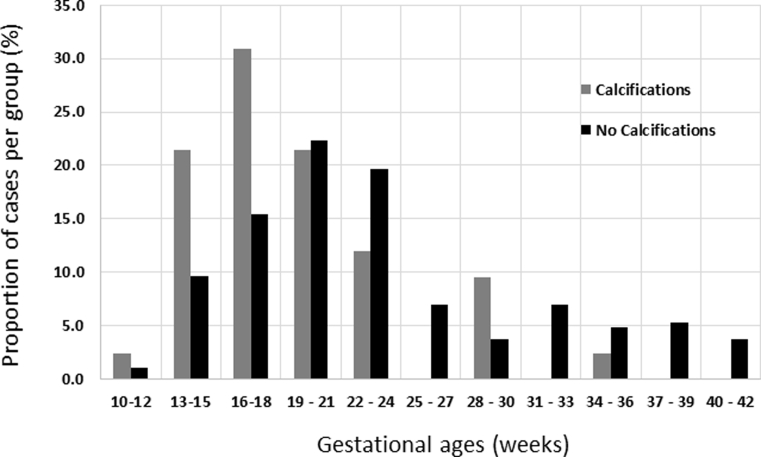
Graph illustrating the proportion (%) of fetuses with and without internal calcifications identified in the present cohort by gestational age. There was a significant difference between the two groups, with calcifications seen more commonly in lower gestational ages.